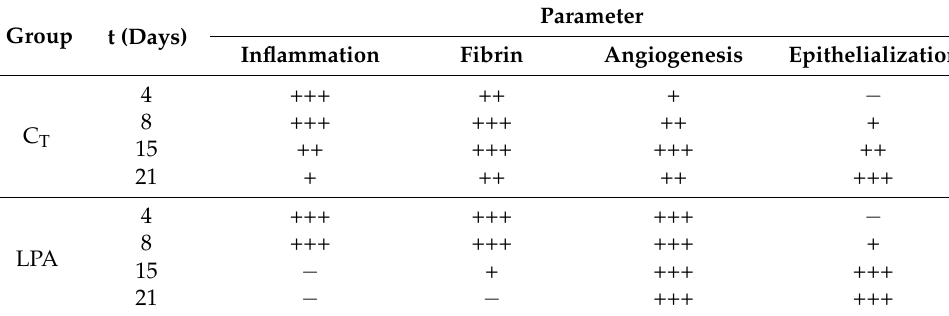
Table 3. Evaluation of histological parameters.